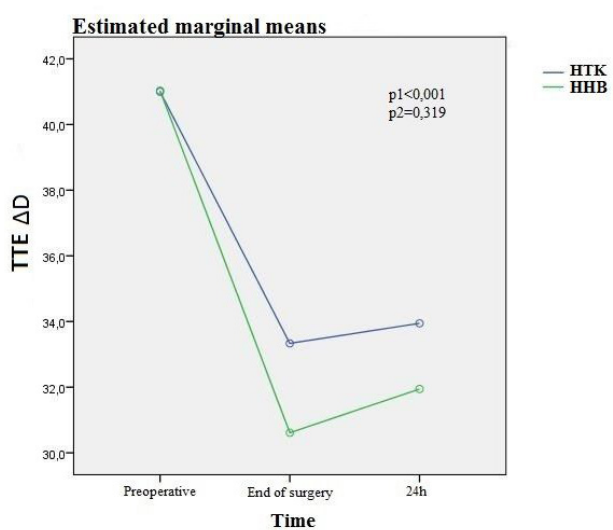
Fig. 4 – Variation of transthoracic echocardiography (TTE) in time (P1) and between groups (P2).